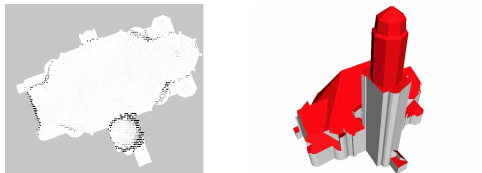
Figure 15: Pictures show error map and model of the church with the largest error.